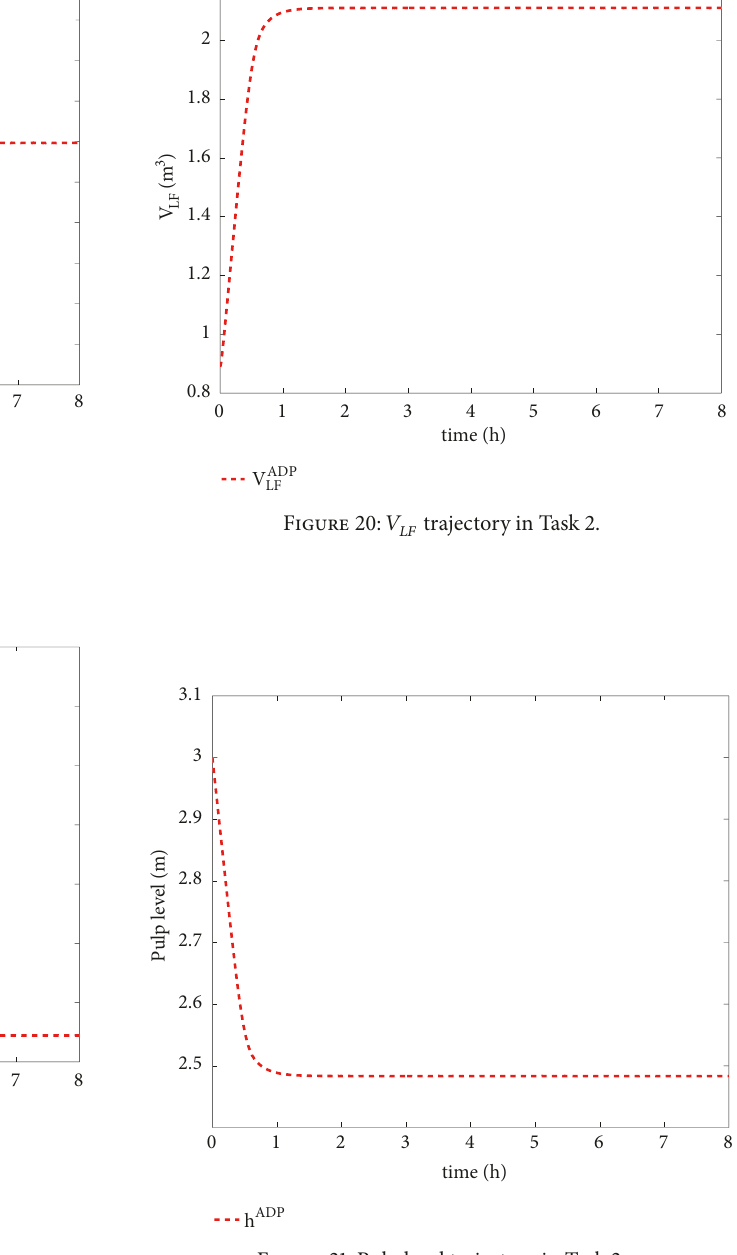
Figure 21: Pulp level trajectory in Task